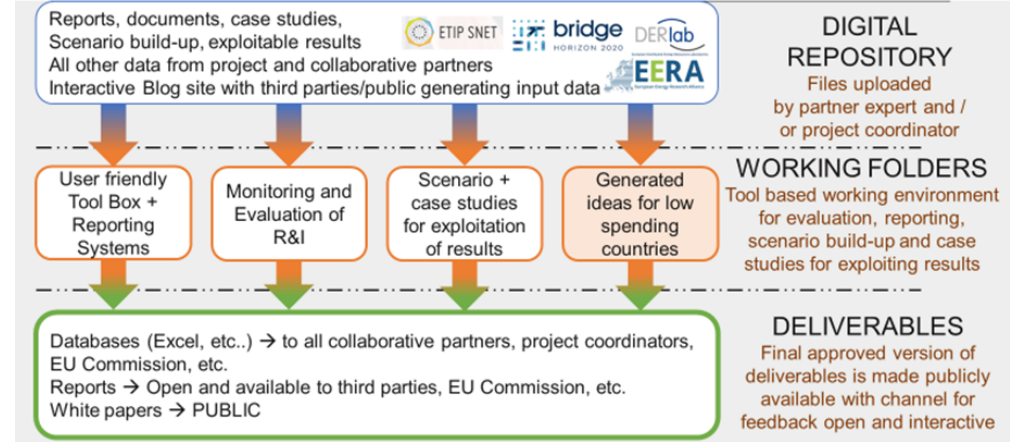
Figure 18. Overview of the ETIP SNET multi-functional collaborative platform